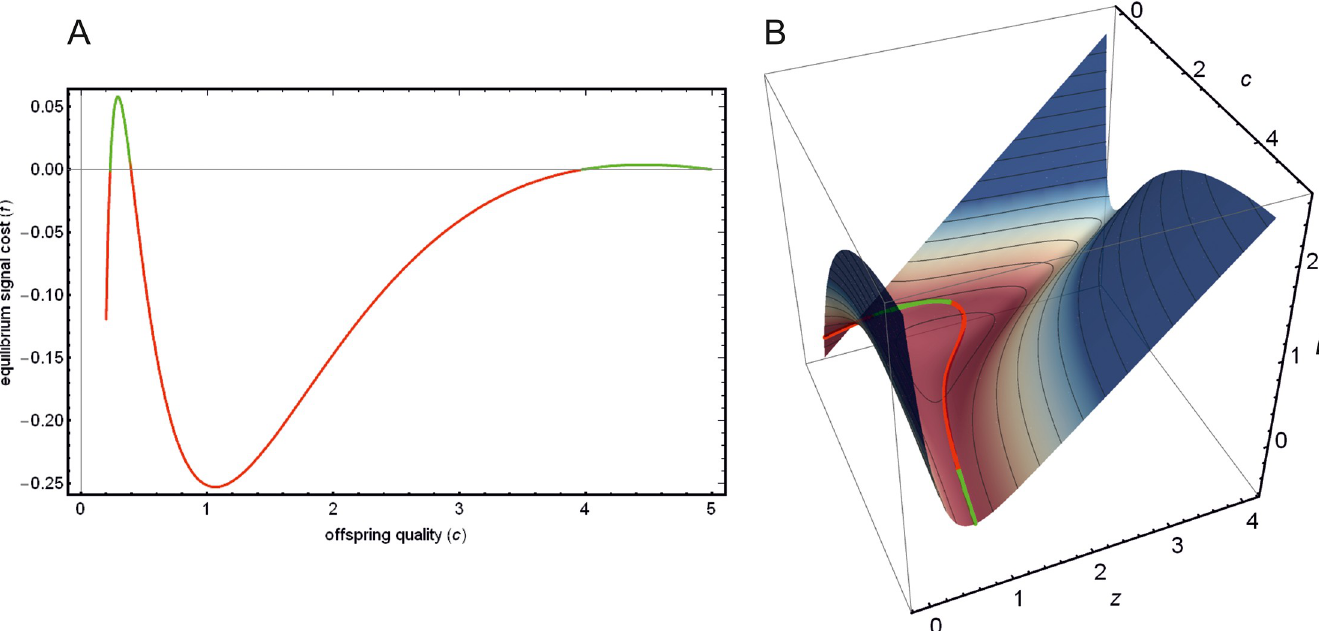
Fig 5. Negative equilibrium cost. (B) Cost of signalling L depending on offspring condition c and amount of transferred resource z (Eq 18). Red-green curve along the surface (and in inset) indicates equilibrium cost function ( f(x � ( c ))) at equilibrium ~ z (Eq 19), where red sections indicate negative cost values. (A) shows this curve projected to the c - f (c) plane. Parameters are: Z ¼ 4 ; G ¼ 0 : 1 ; U ¼ 1 ; g ¼ 1